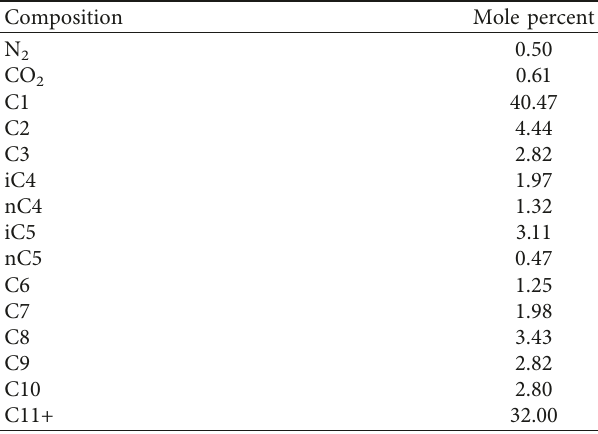
Table 2: Crude oil composition.